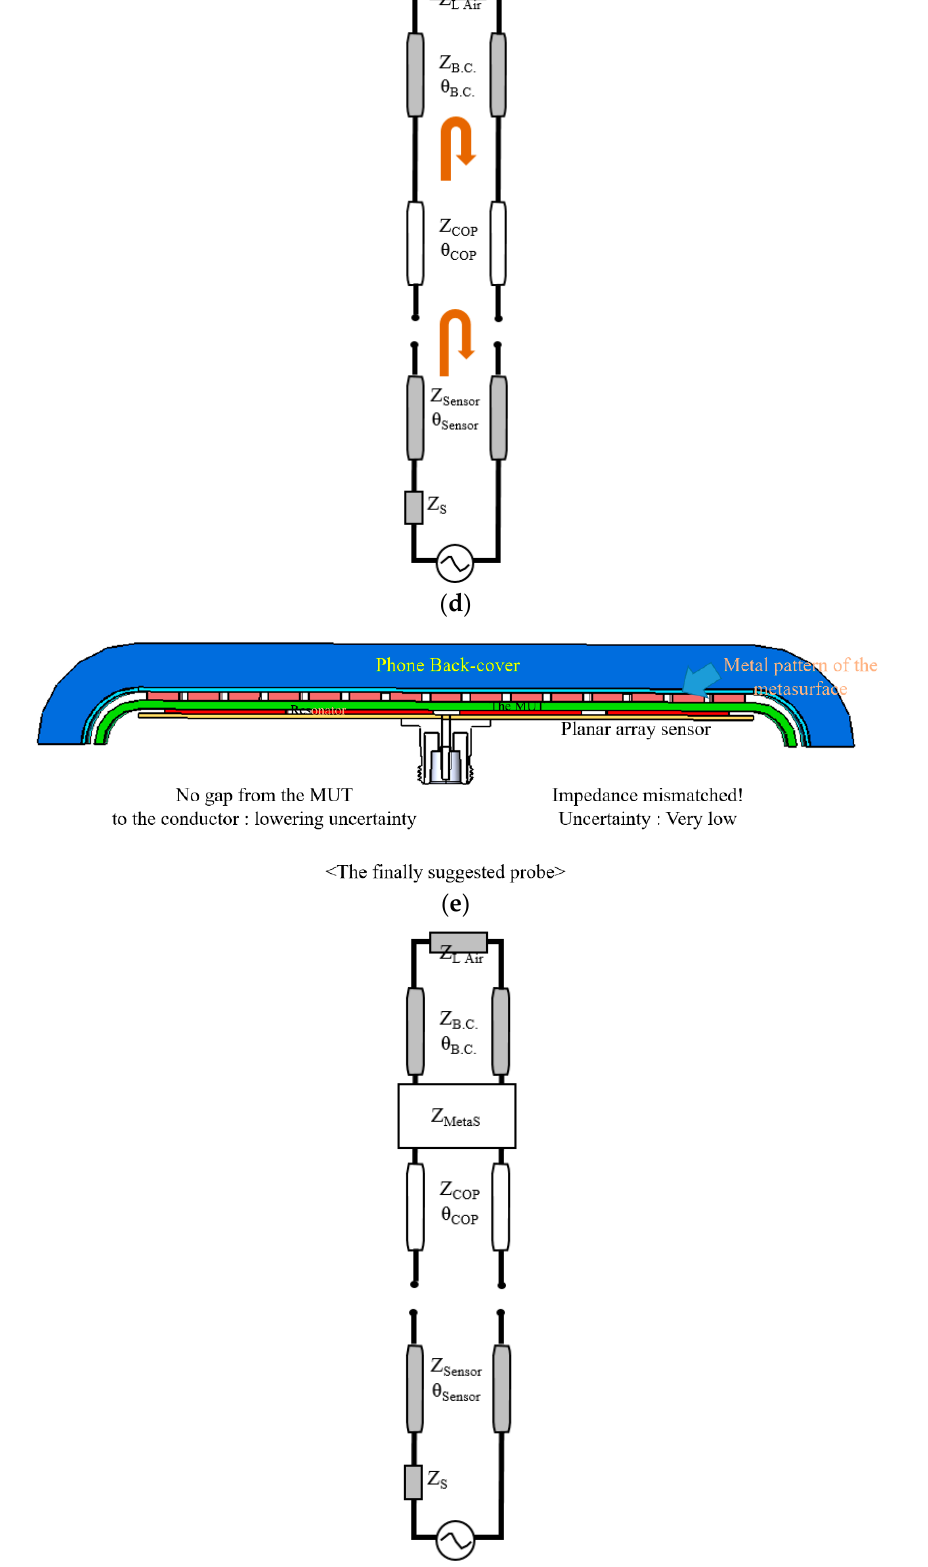
Figure 3. 2D views of the sensor contacting the back-cover with changing conditions and their equivalent circuit models. ( a ) Original case. ( b ) Circuit model of ( a ). ( c ) Initially suggested probe. ( d ) Circuit model of ( c ). ( e ) Finally suggested probe. ( f ) Circuit model of ( e ).